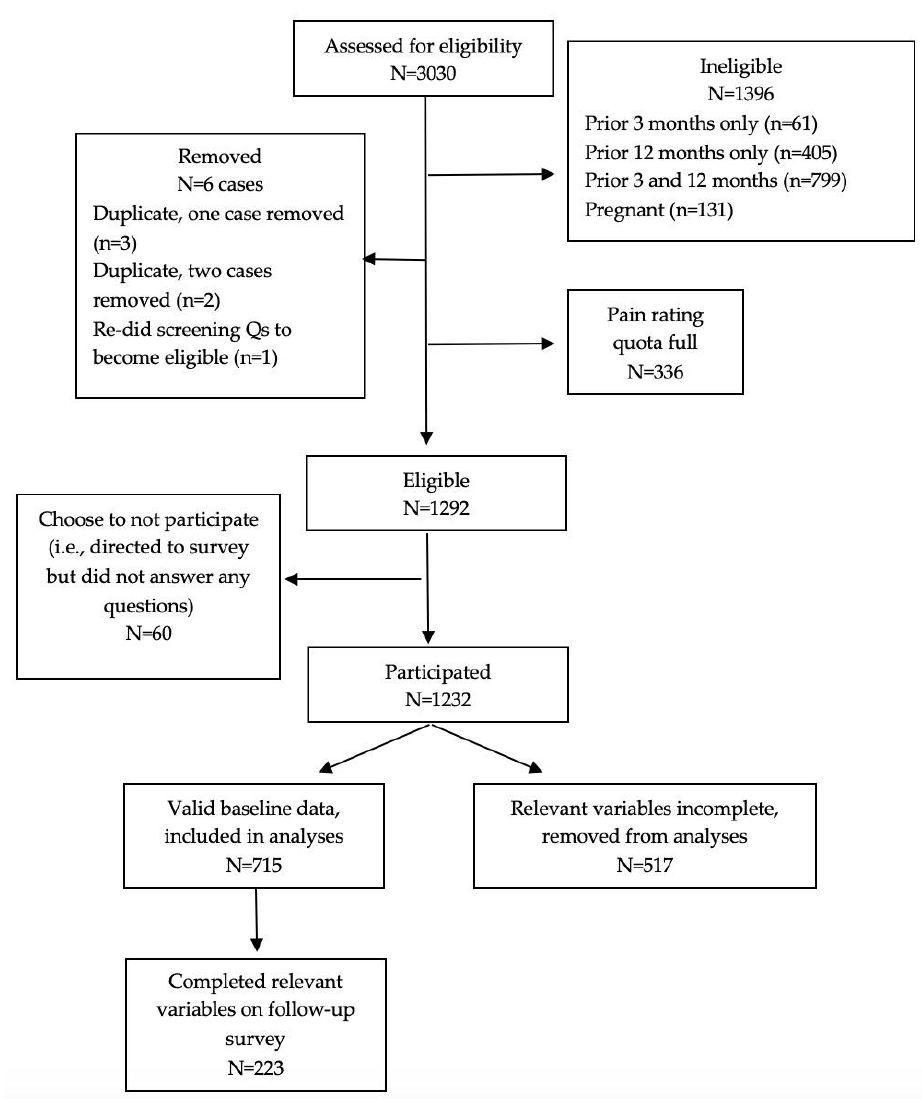
Figure 1. Enrollment flow diagram.